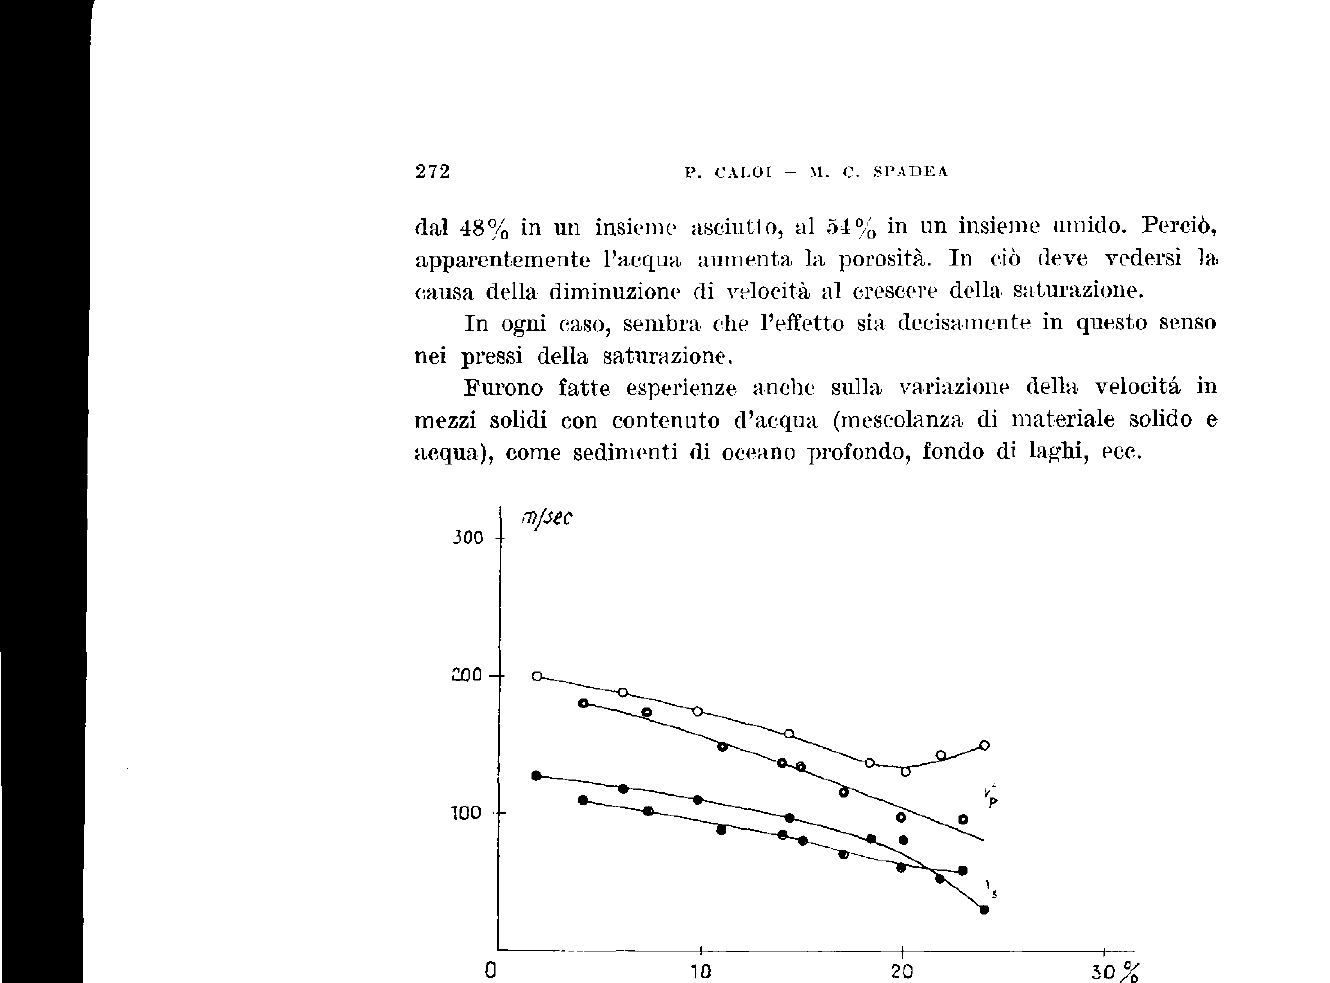
Fig. 9 - Velocità delle onde longitudinali e trasversali in funzione del contenuto d'acqua (secondo K.